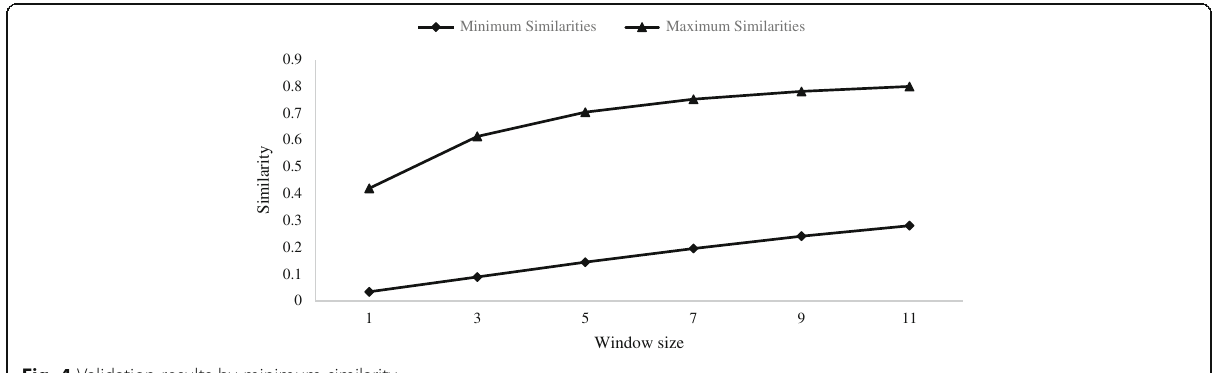
Fig. 4 Validation results by minimum similarity